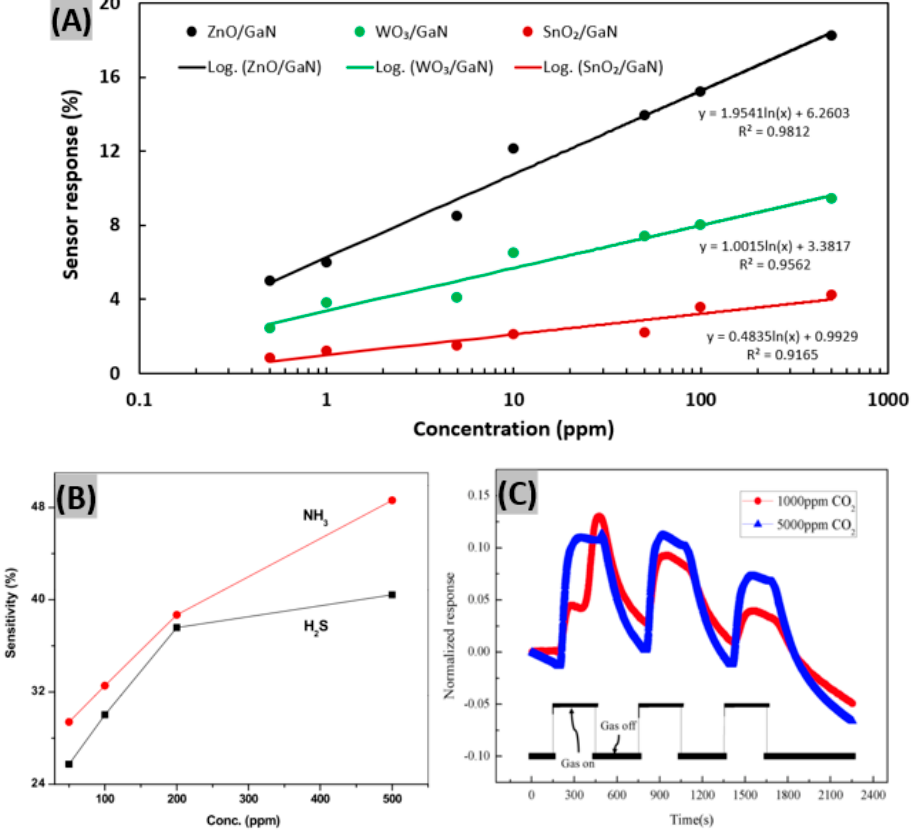
Figure 5. ( A ) SO 2 gas response fitting lines for the ZnO/GaN NW sensor (black), WO 3 /GaN NW sensor (green) and SnO 2 /GaN NW sensor (red) under UV light at room temperature (20 °C). Figure adapted with permission from [63], Copyright 2020 Elsevier. ( B ) The plotting of sensitivity variation of GaN nanoparticles for H 2 S and NH 3 gas at 300 K. Figure adapted with permission from [38], Copyright 2010 Elsevier Ltd. ( C ) Normalized responses of metal-oxide coated GaN NW sensor device for 1000 and 5000 ppm of CO 2 gas under UV light. Figure adapted with permission from [64], Copyright 2018 ICES.